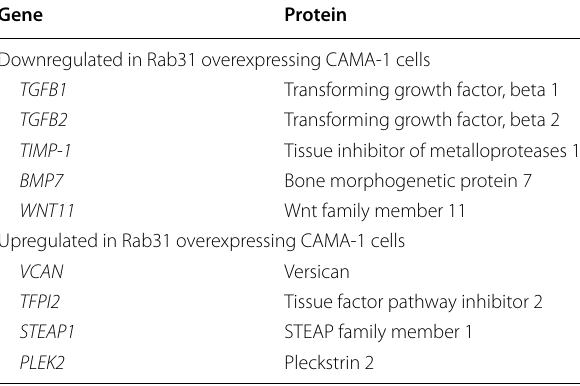
Table 1 Differentially expressed EMT-related candidate genes in Rab31 overexpressing and vector control cells identified by profiler PCR array